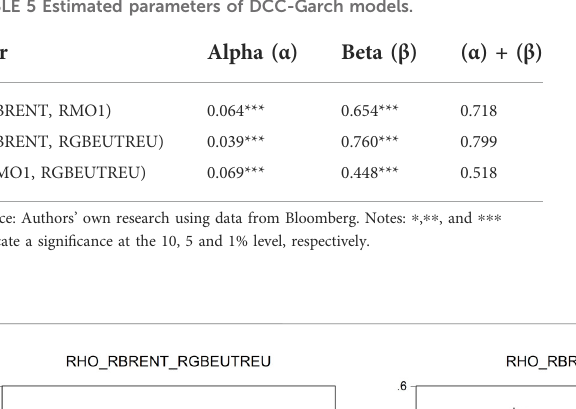
TABLE 5 Estimated parameters of DCC-Garch models.